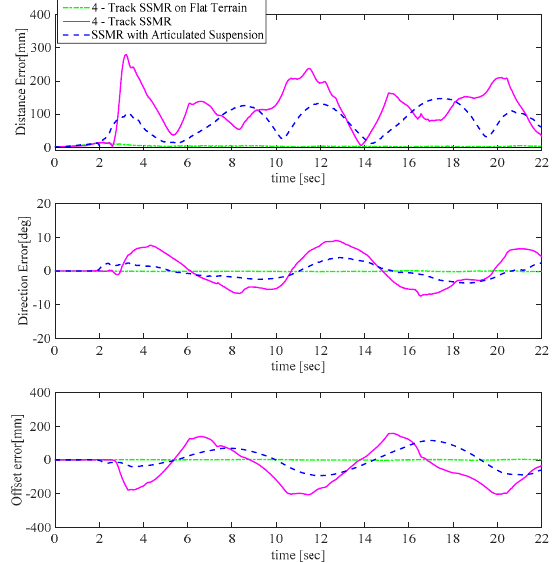
Figure 10. Comparison results of distance, direction, and offset errors of a non-suspension version of four track SSMR and PASTRo on flat and sinusoidal terrain: distance error, direction error, and offset error.